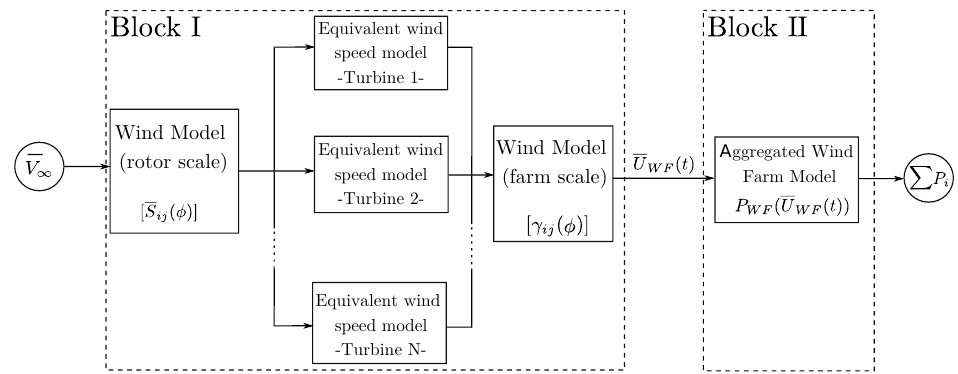
Figure 4. Wind farm power simulator